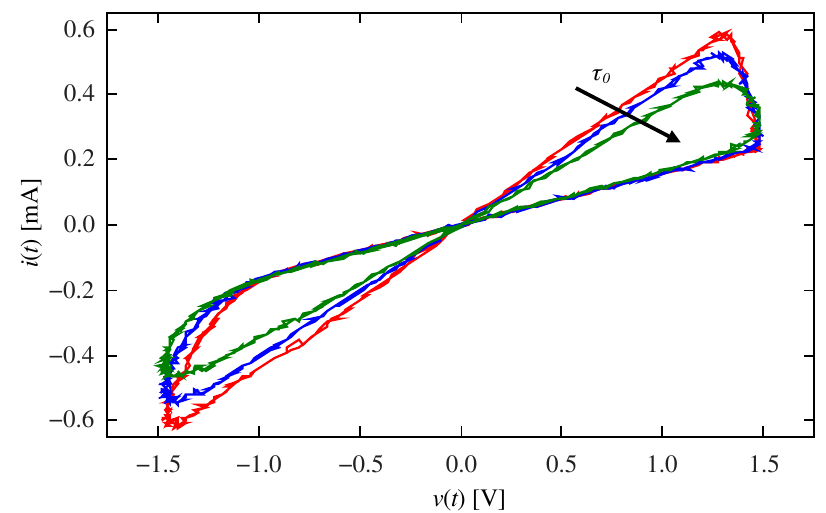
Figure 6. Circuit current vs. memristor voltage: measured emulator results. The AWG provides a 1 Hz sinusoidal signal with amplitude A = 1.5V. Parameters were set to α R on = 1 k Ω , R off = 5 k Ω , and v 0 = 0.2 V. The device’s response time was varied: τ 0 = 5, 10, 20 s (red, blue, and green lines, respectively). Extreme memristance values depend on the value τ 0